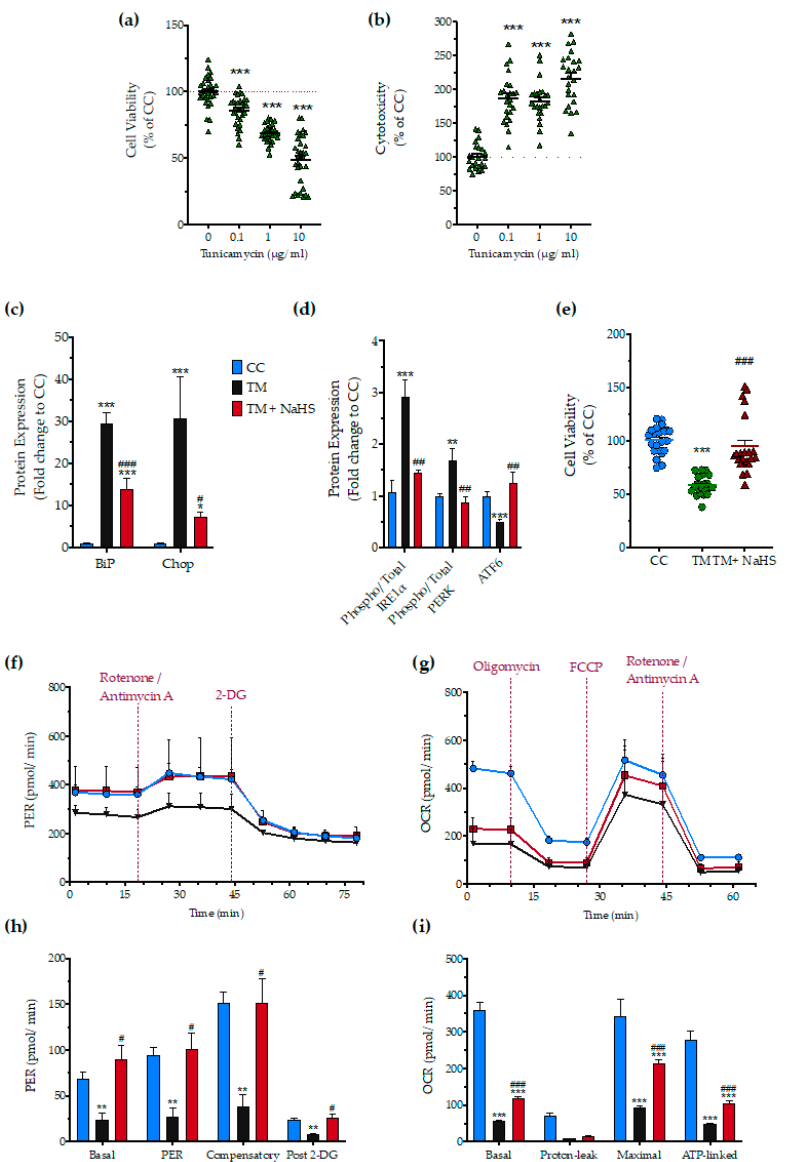
Figure 13. No-calcium dependency in the hepatoprotective effects of NaHS under conditions of persistent ER stress. HepG2 cells serum-starved for 8 h and treated with 0, 0.1, 1, and 10 µg/mL of tunicamycin (TM) for 16 h for stressor concentration optimization. Micro-cultures were assayed for the XTT conversion ( a ) to assess cell viability. Cell supernatant was collected and processed for the LDH activity ( b ) to determine cytotoxicity. We selected the concentration of 1 µg/mL of tunicamycin for the experiments. For the subsequent experiments, HepG2 cells were treated with the vehicle or 1 µg/mL of tunicamycin, with/without 100 µM NaHS for 16 h. Following the treatment incubation, whole-cell lysate was collected and processed for protein expression of the UPR sensors-BiP ( d ), IRE1 α (activating phosphorylation at Ser724), PERK (activating phosphorylation at Thr 980), and total ATF6 ( c ). We additionally quantified the expression levels of the UPR apoptotic mediator-Chop (c) . Micro-cultures were assayed for XTT conversion ( e ) or cellular bioenergetic function using the Seahorse XFe24 Extracellular Flux Analyzer for assessing oxidative phosphorylation ( f , h ) and glycolysis ( g , i ). Each graph line and bar represent mean ± SEM from three independent experiments. Data are expressed as a percentage or fold change of the control, untreated / unstressed conditions (CC). * p ≤ 0.05, ** p ≤ 0.01 and *** p ≤ 0.001 compared to corresponding CC; # p ≤ 0.05, ## p ≤ 0.01 and ### p ≤ 0.001 compared to the corresponding TM-treated